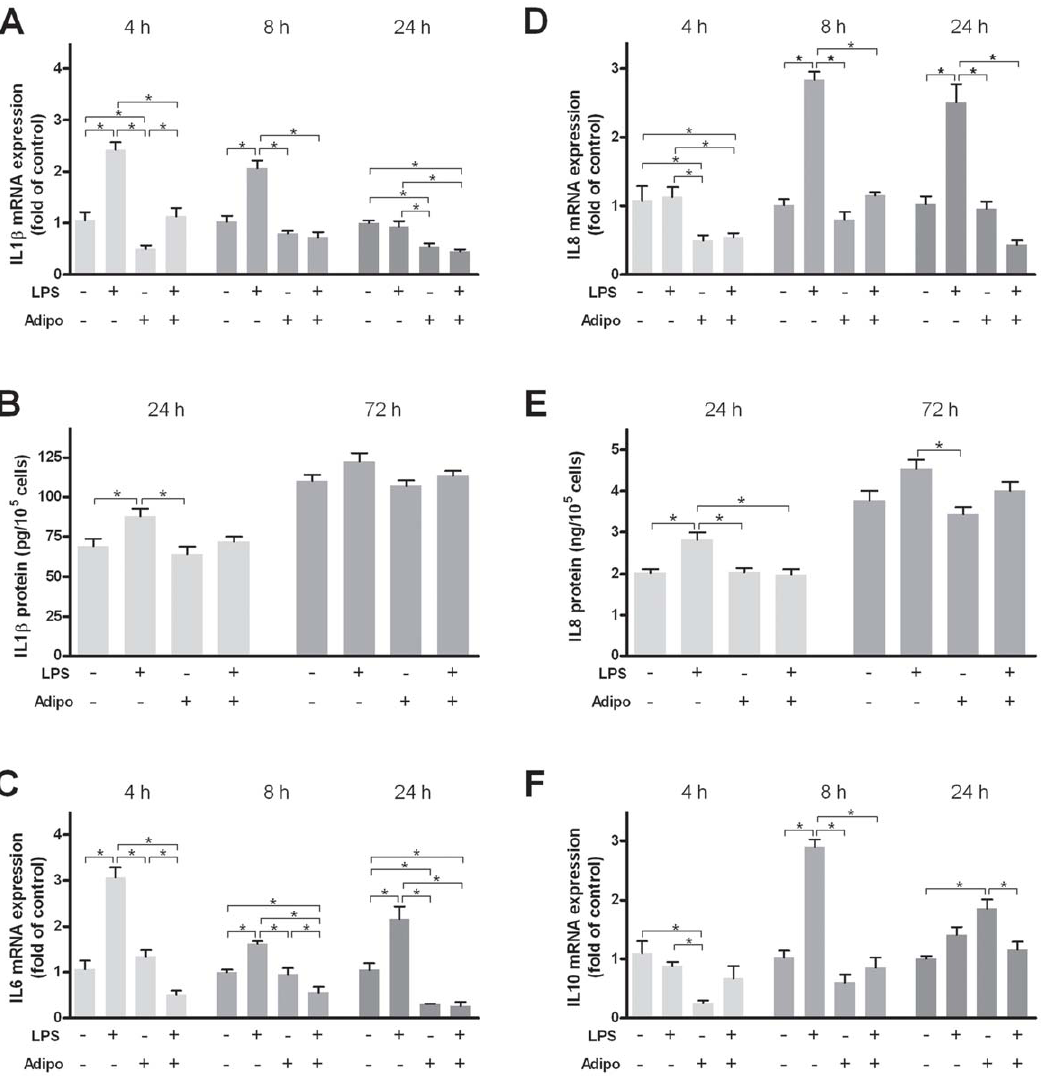
Figure 4. Interactions of lipopolysaccharide and adiponectin on pro- and anti-inflammatory mediators. Effects of lipopolysaccharide (LPS; 2 m g/ml) and/or adiponectin (Adipo; 1 m g/ml) on the mRNA expression of IL1 b (A), IL6 (C), IL8 (D), and IL10 (F) at 4 h, 8 h, and 24 h and on the protein level of IL1 b (B) and IL8 (E) in supernatants at 24 h and 72 h. Mean 6 SEM; n=6; * p , 0.05 difference between groups.